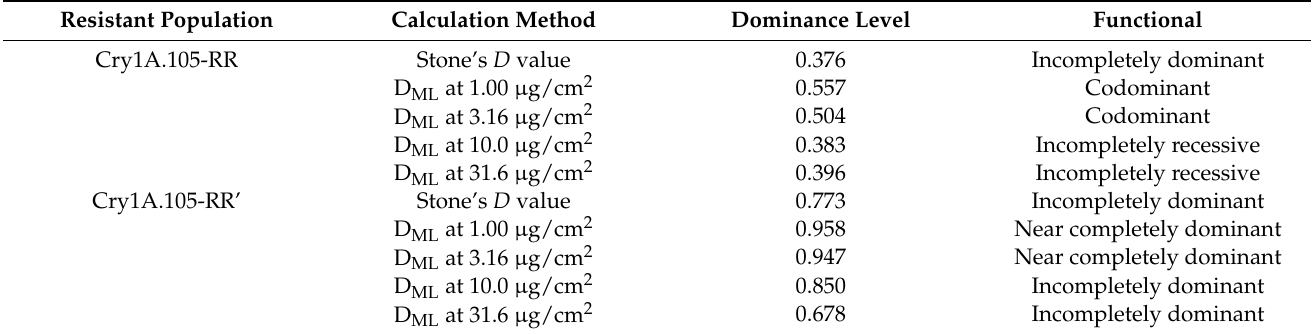
Table 3. Stone’s ( D ) and effective dominance (D ML ) levels of Cry1A.105 resistance in H. zea